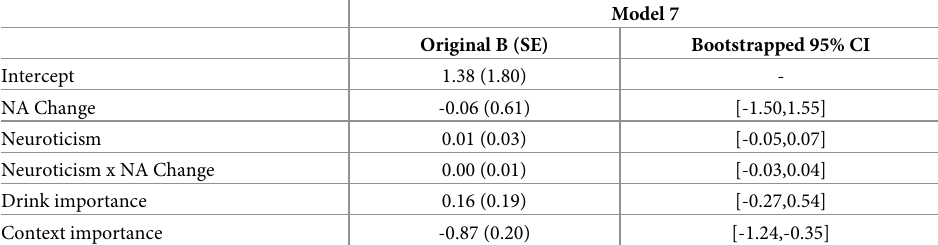
Table 7. Coefficients based on the original data and bootstrapped 95%CIs.